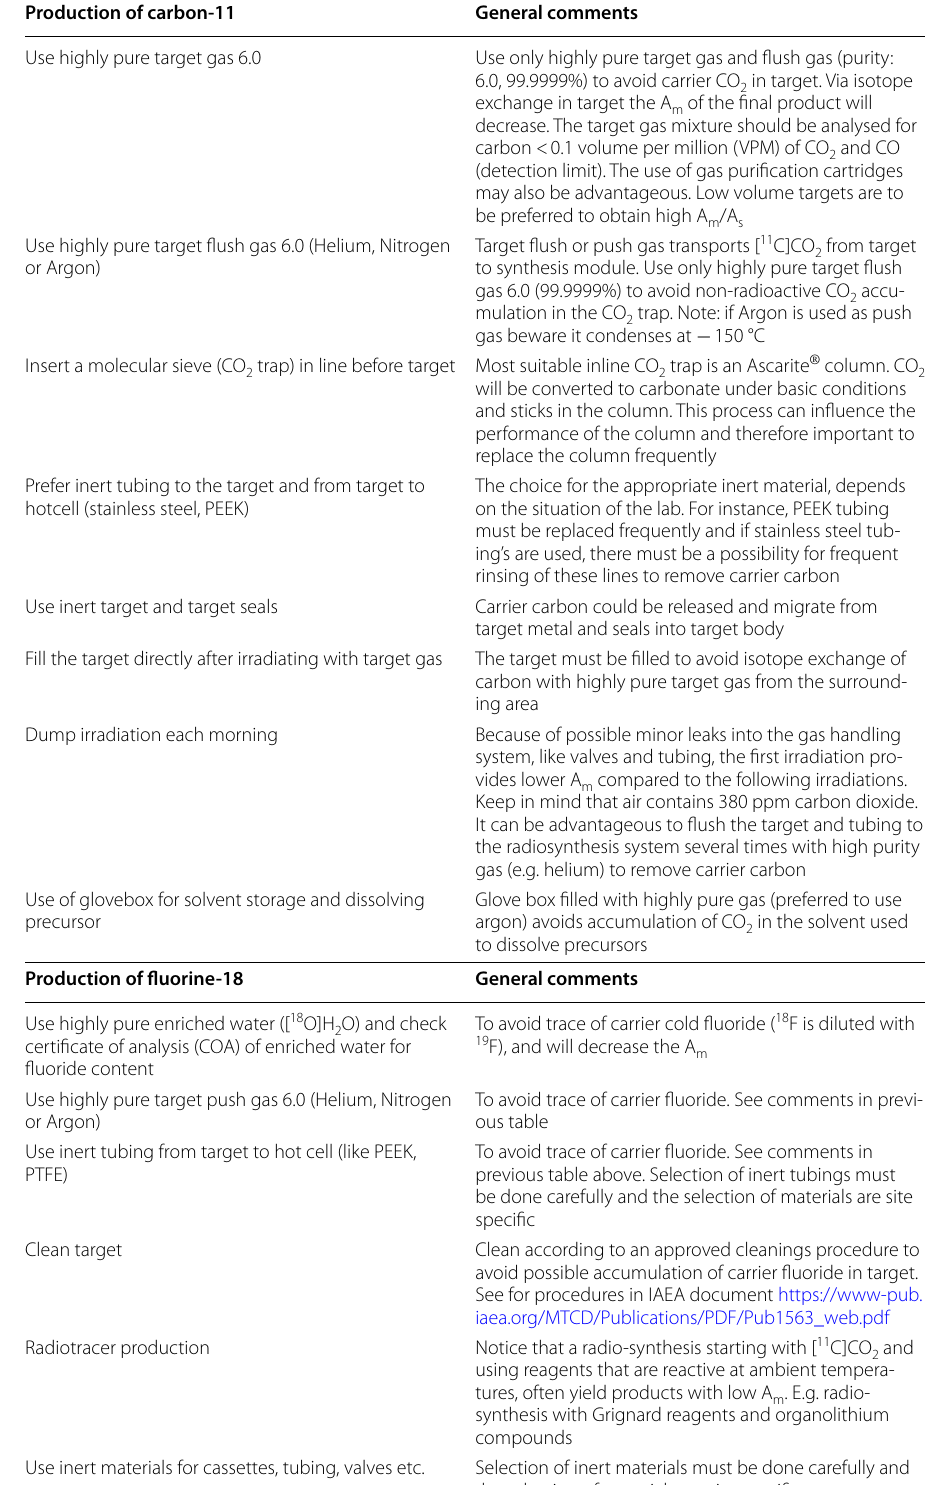
in C-11 and F-18 productions m